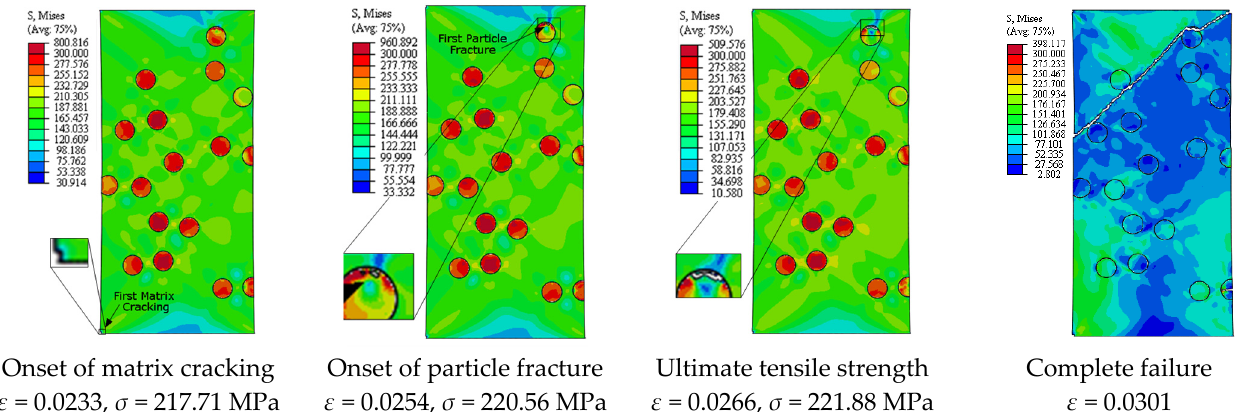
Figure 16. Failure propagation and von Mises stress distribution of A359/SiC composite at PS = 15 µm (10% VF).